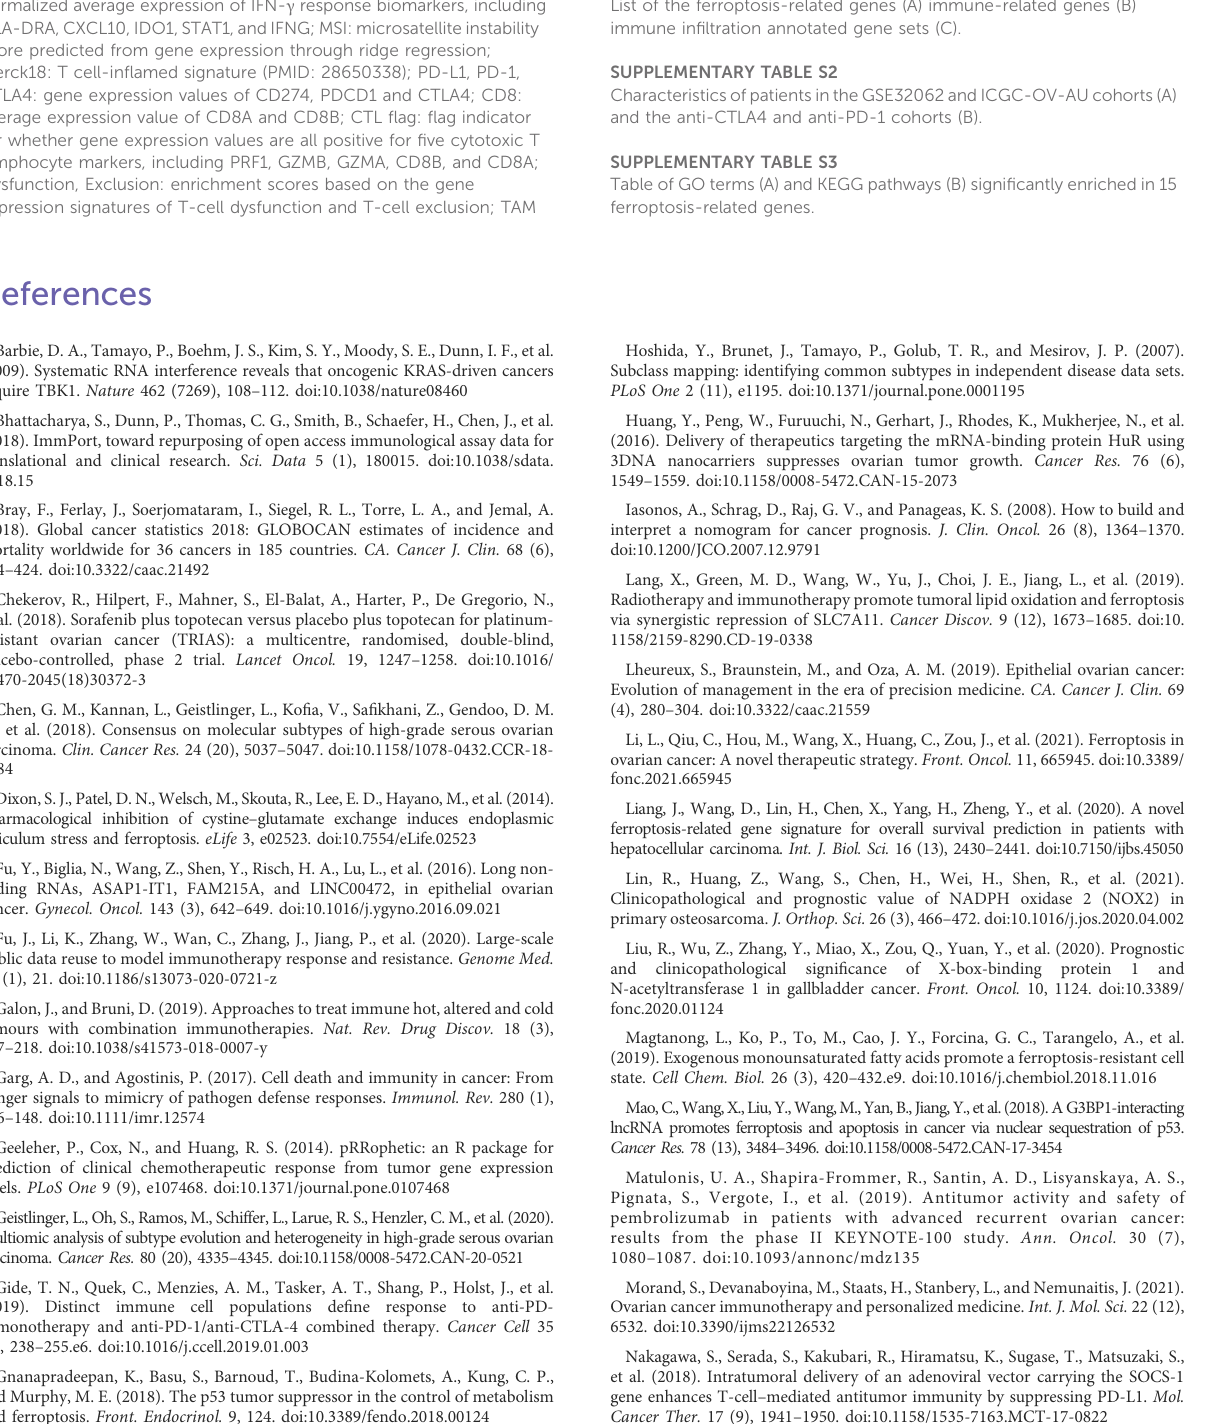
SUPPLEMENTARY TABLE S1 List of the ferroptosis-related genes (A) immune-related genes (B) immune in fi ltration annotated gene sets (C). SUPPLEMENTARY TABLE S2 CharacteristicsofpatientsintheGSE32062andICGC-OV-AUcohorts(A) and the anti-CTLA4 and anti-PD-1 cohorts (B). SUPPLEMENTARY TABLE S3 Table of GO terms (A) and KEGG pathways (B) signi fi cantly enriched in 15 ferroptosis-related